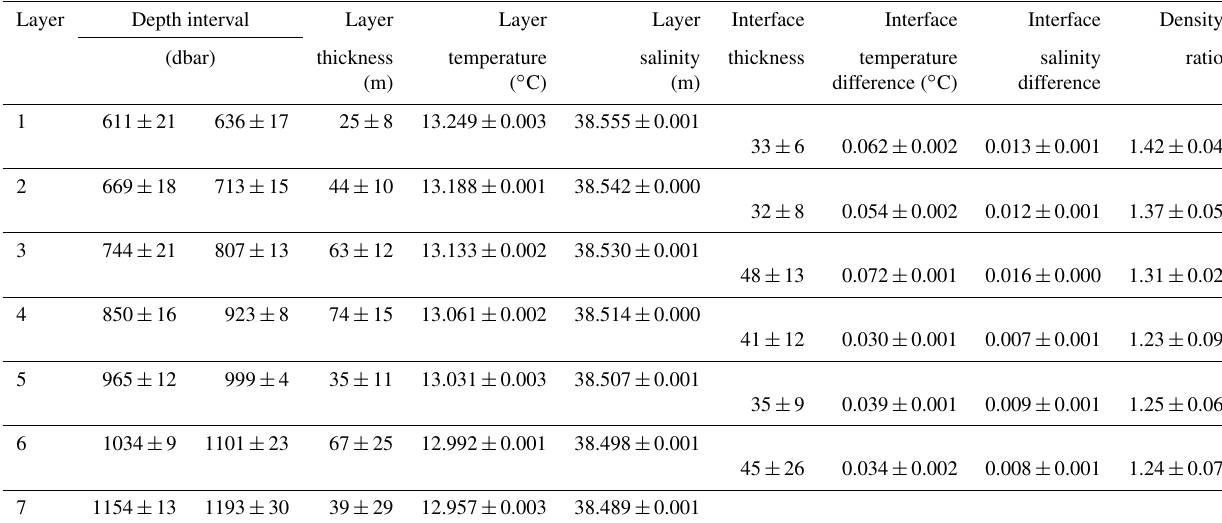
Table 4. Characteristics of the staircases in the Algerian Basin, extracted from the nine casts carried out during the PEACETIME cruise (Fig. 7). The selected layers are thicker than 15m. The layer numbering increases with depth. Parameters are presented as the average value and standard deviation over the nine casts